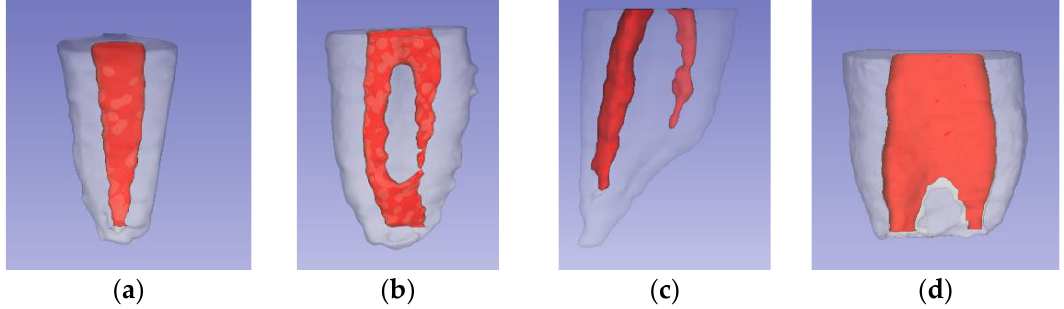
Figure 3. Weine’s classification of root canal [20]: ( a ) Type I: single canal and apex; ( b ) Type II: two canals fused at the apical level; ( c ) Type III: two canals and two apexes; ( d ) Type IV: single canal that divides and ends in two apexes.